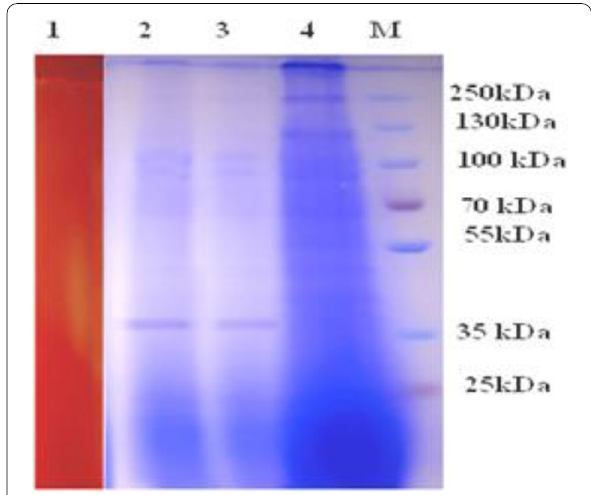
Fig. 15 Zymogram of xylanase, 2‑4 SDS‑PAGE of partially purified xylanase from A. terreus RGS.Eg‑NRC